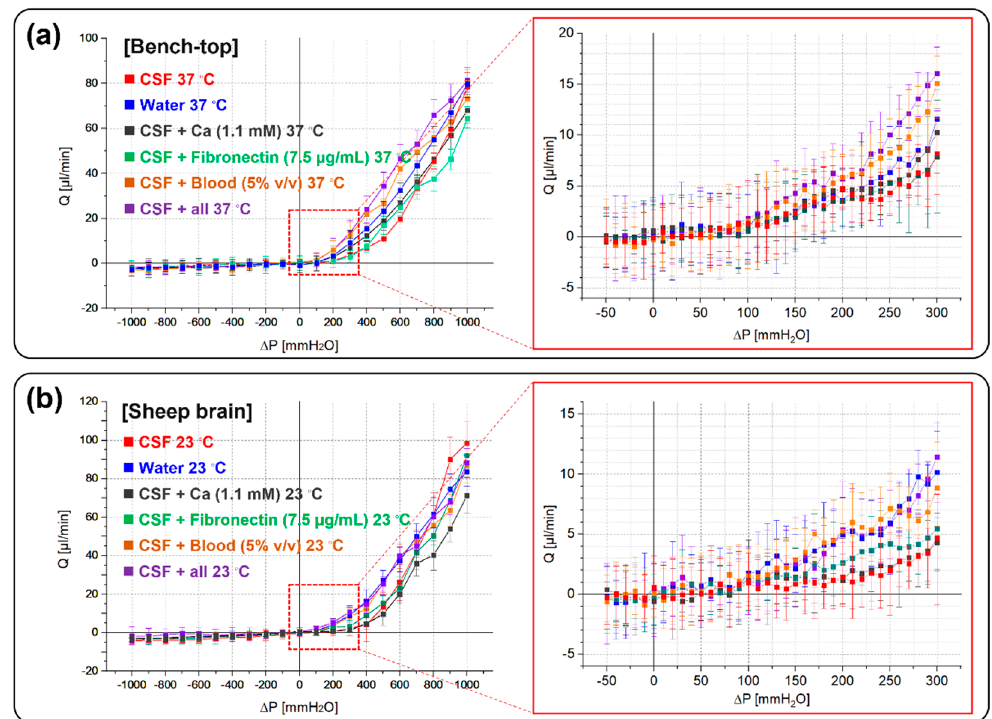
Figure 4. A series of increasingly worst-case fluidic conditions were used to emulate short-term conditions related to various failure modes seen in traditional shunt systems, namely occlusion due to foreign body response, fibrous encapsulation, and mineralization due to calcification. The functional tests were performed on ( a ) bench-top and ( b ) in vitro fixed sheep brain setups. The hydrogel check-valve remained functional, with a reasonable cracking pressure range and negligible reverse flow leakage. The detailed results of the valve’s functionalities are described in Table 1. Summary of specifications for hydrogel valves tested in worst-case environments.